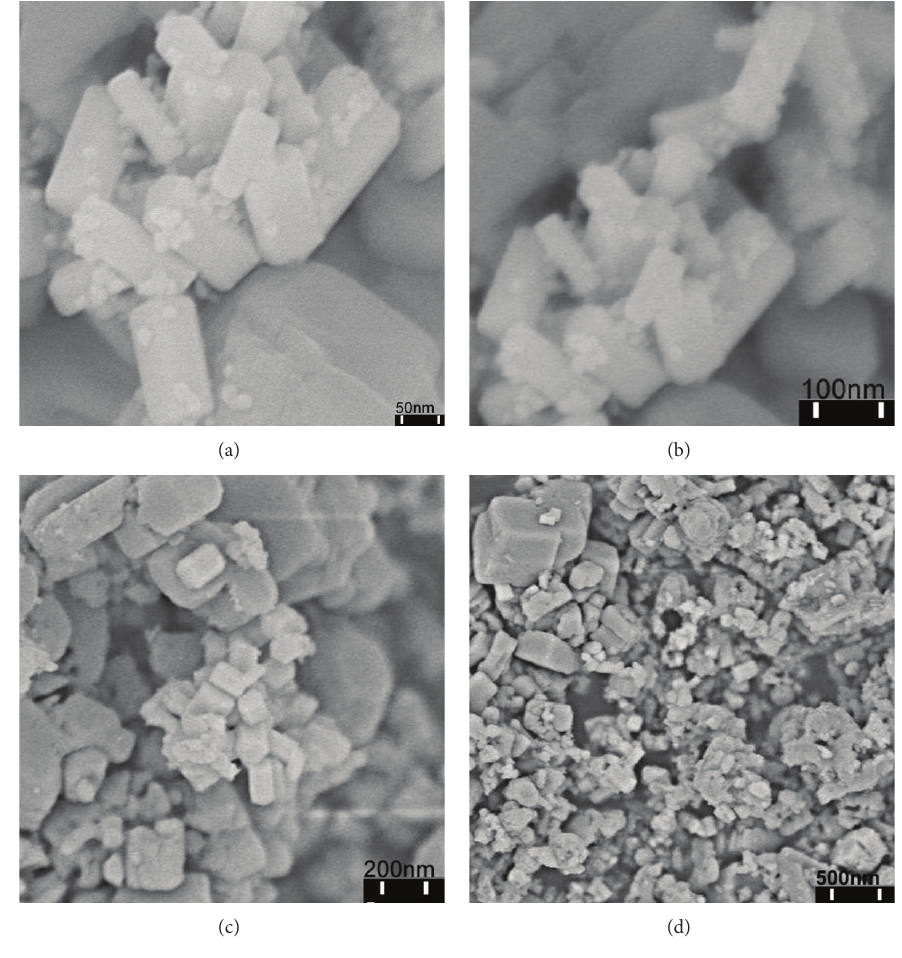
Figure 2: SEM graph of the synthesized nanocrystals.